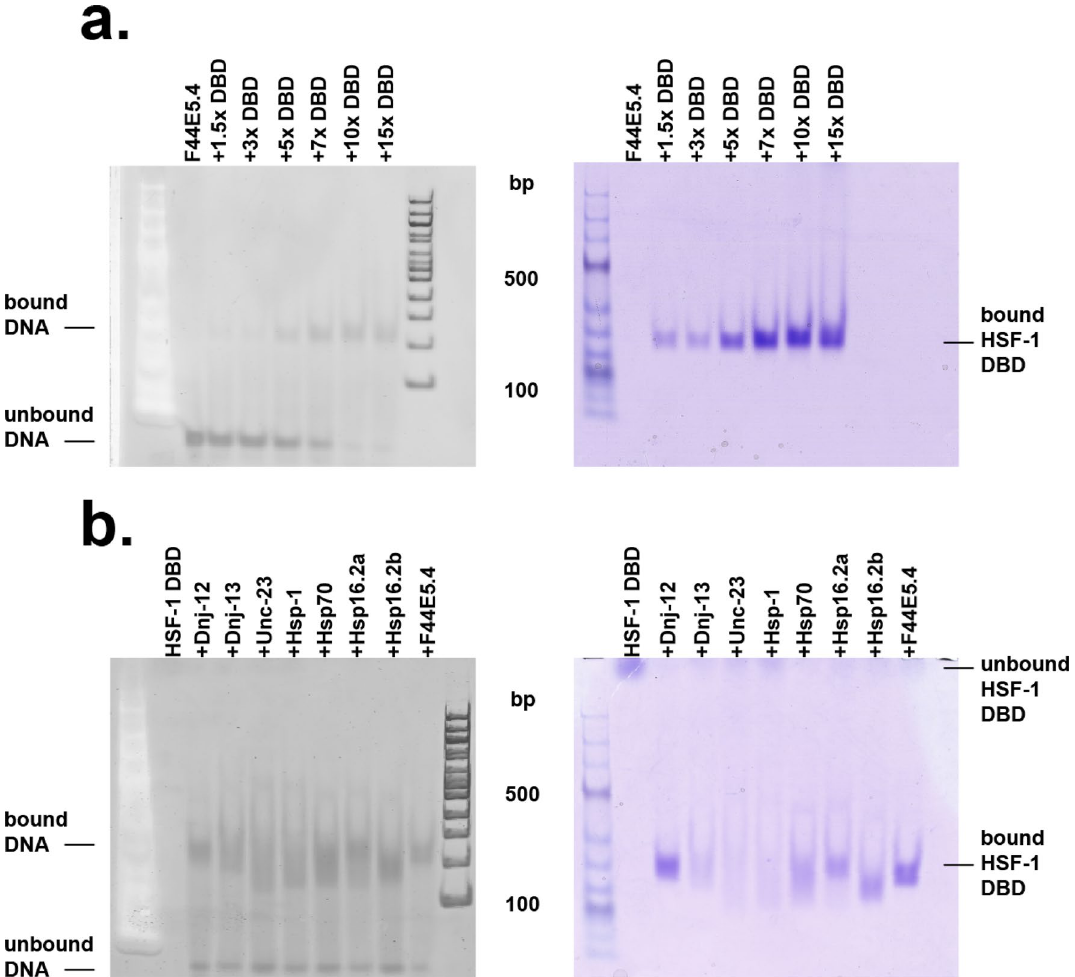
Figure 3. EMSA shift of the DNA-HSF-1 complex. The DNAs were stained with the DNA stain (left gel) whereas proteins were stained with Coomassie Blue (right gel). DNA-DBD binding occurs when both stained DNA and stained protein overlap, in comparison to each other. ( a ) Titration of HSF-1 DBD to the promotor F44E5.4, ranging from a 1,5–15-fold excess of HSF-1 DBD; ( b ) Comparison of selected DNA promotor sequences, each added to the HSF-1